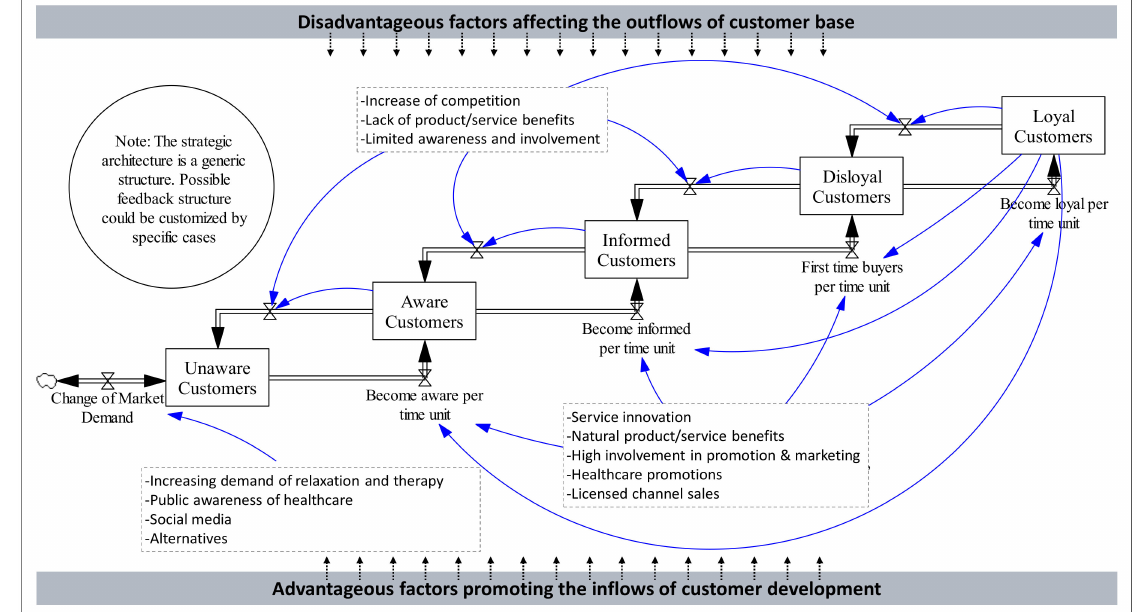
Figure 2. Strategic architecture of market development in the Essential Oil and Aromatherapy